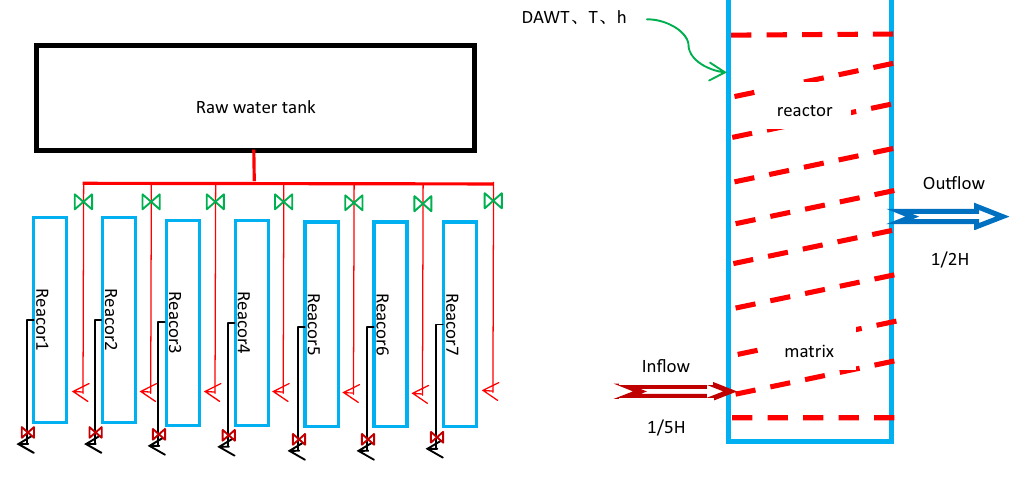
Figure 1: Experimental